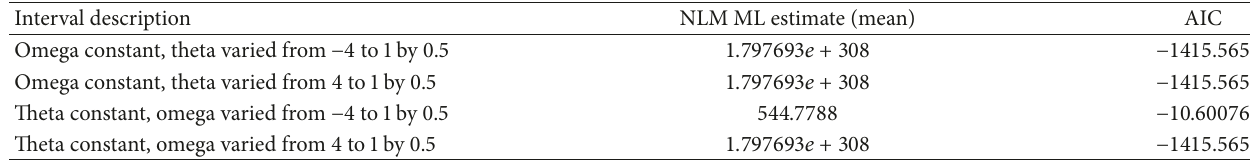
Table 9: Summary of results for lambda = 0.8, 𝑛 = 10 𝑖 , 𝑖 = 4